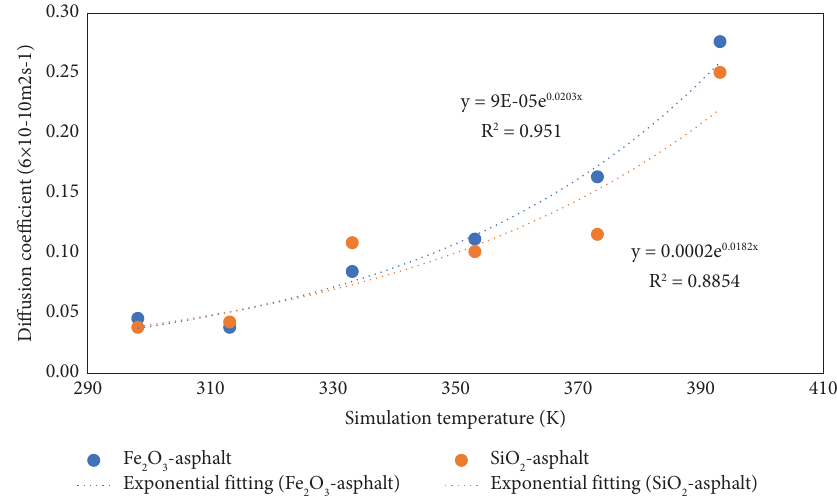
Figure 9: Relationship between difusion coefcient and simulation